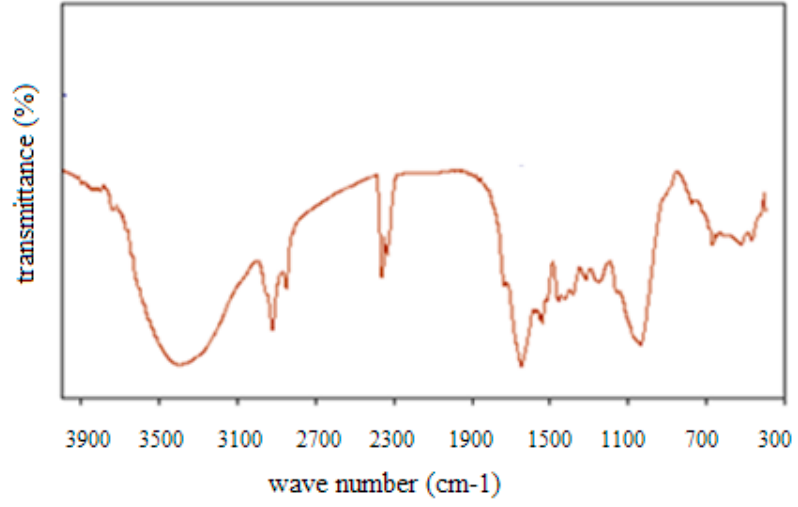
Figure 2. FTIR of olive mill solid waste.